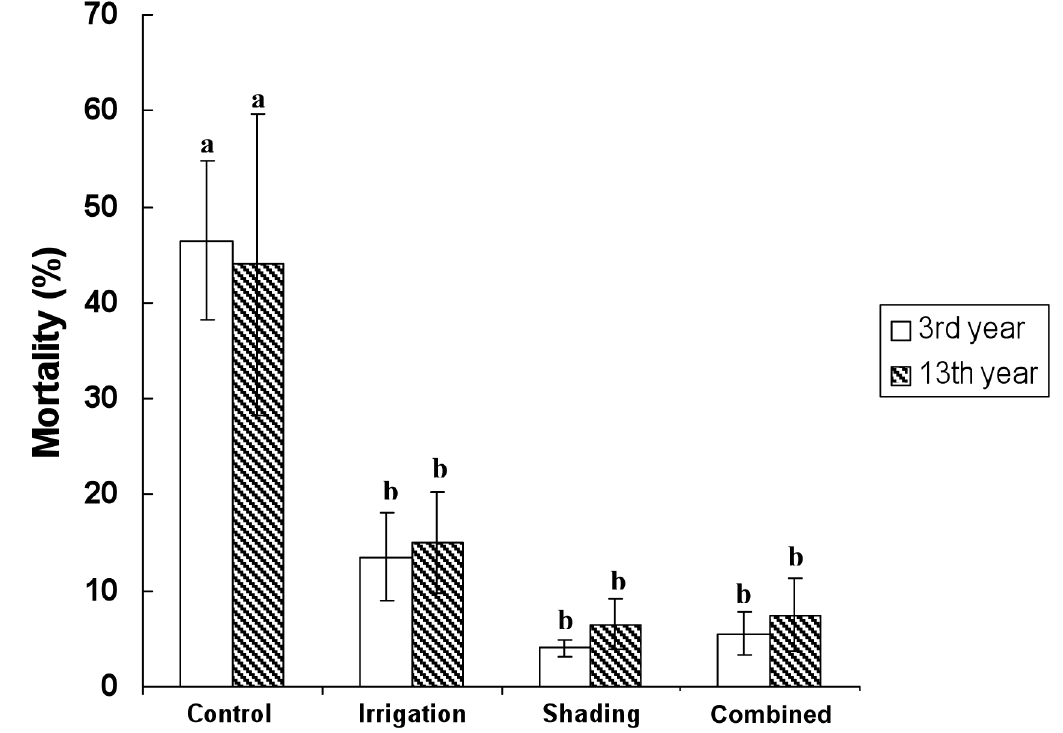
Fig. 1. Shaded bars: cumulative mortality of planted Q. ilex trees under different combinations of summer irrigation and artificial shading applied for three years and an additional ten-year post-treatment period (F = 9.32, p = 0.0015, R 2 = 68.9%). Open bars: 3, 11 mortality at the end of the treatment period reported by Rey Benayas (1998). Note: mortality counts during the entire 13-year period are lower than mortality counts during the first three years in control plots because resprouting of apparently dead saplings outweighed additional mortality. Different letters mean statistical differences within a year (3rd or 13th) at p = 0.05 according to a Tukey’s test. Data are mean values ±